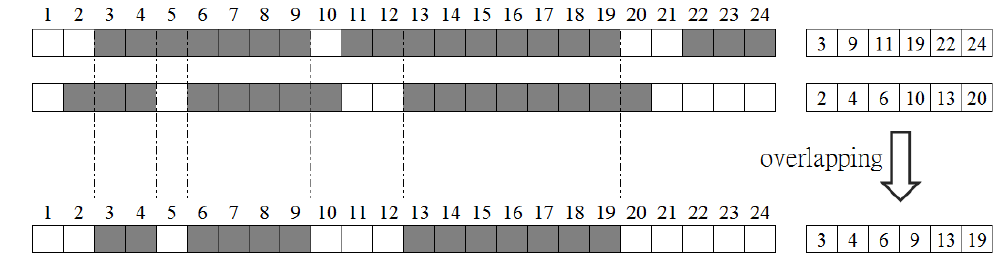
Figure 2. Identification of overlapping hours in which states of both chromosomes are on and resulting proto-offspring.